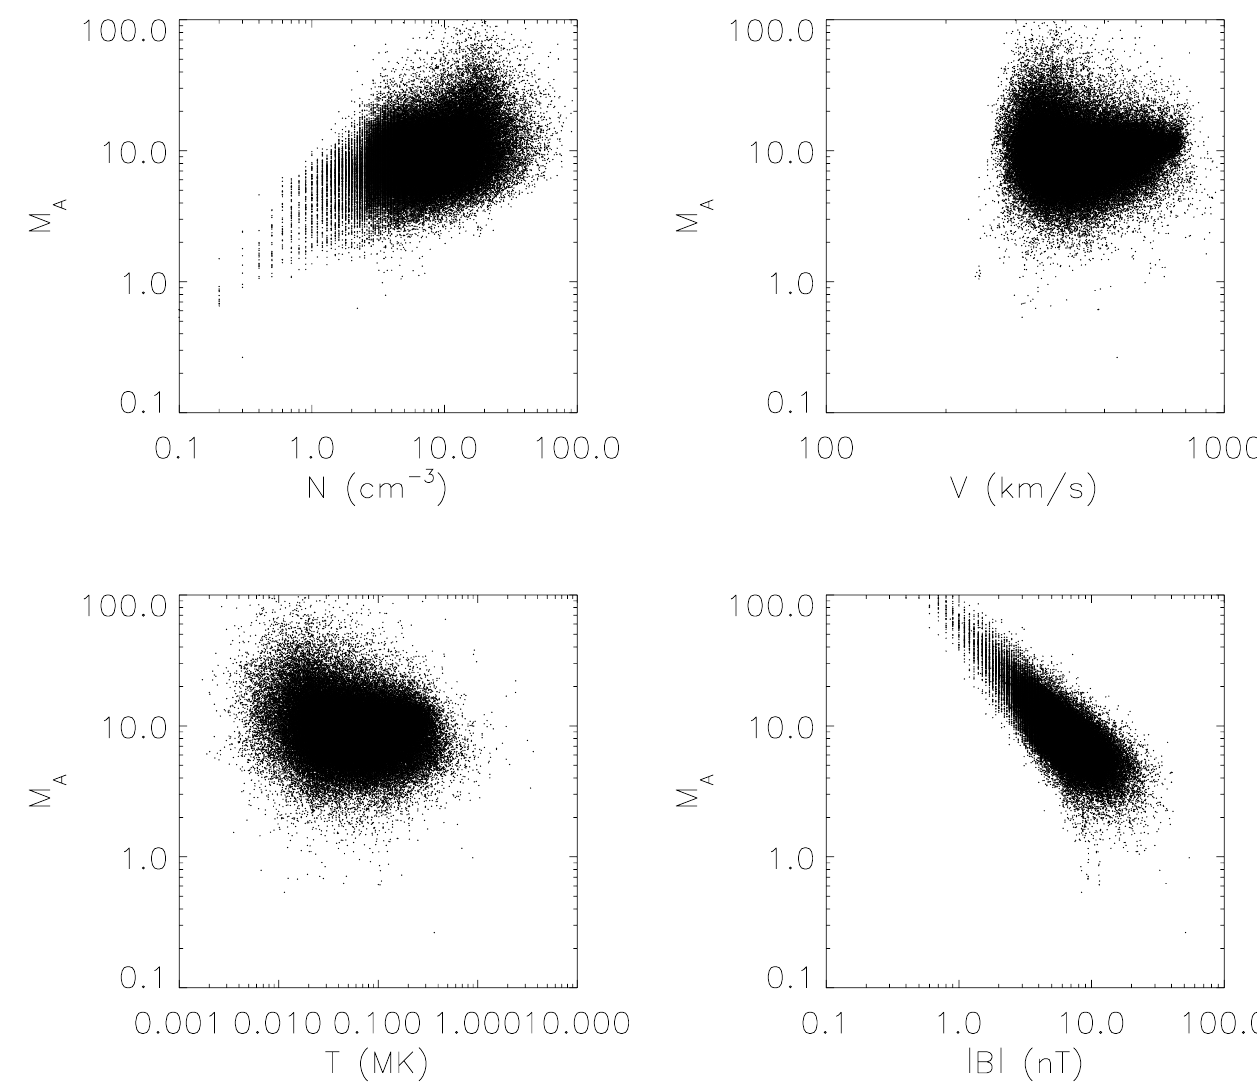
Fig. 6. Scatter plots of density ( N ) and Alfven Mach number ( M A ), speed ( V ) vs. M A , temperature ( T ) vs. M A , and magnetic intensity ( | B | ) vs. M A